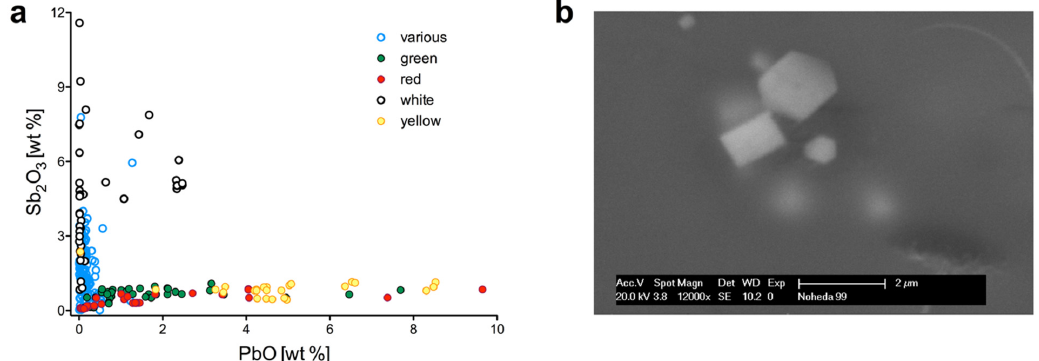
Figure 4. Antimony compounds as opacifiers. ( a ) Lead and antimony concentrations show the separation between calcium antimonate (blue, grey, turquoise, white) and lead antimonate (green, yellow) opacified tesserae. Some white and blue samples have elevated lead contents. ( b ) Back-scattered scanning electron microscope (SEM) image of newly formed hexagonal and cubic calcium antimonate crystals in a white tessera.